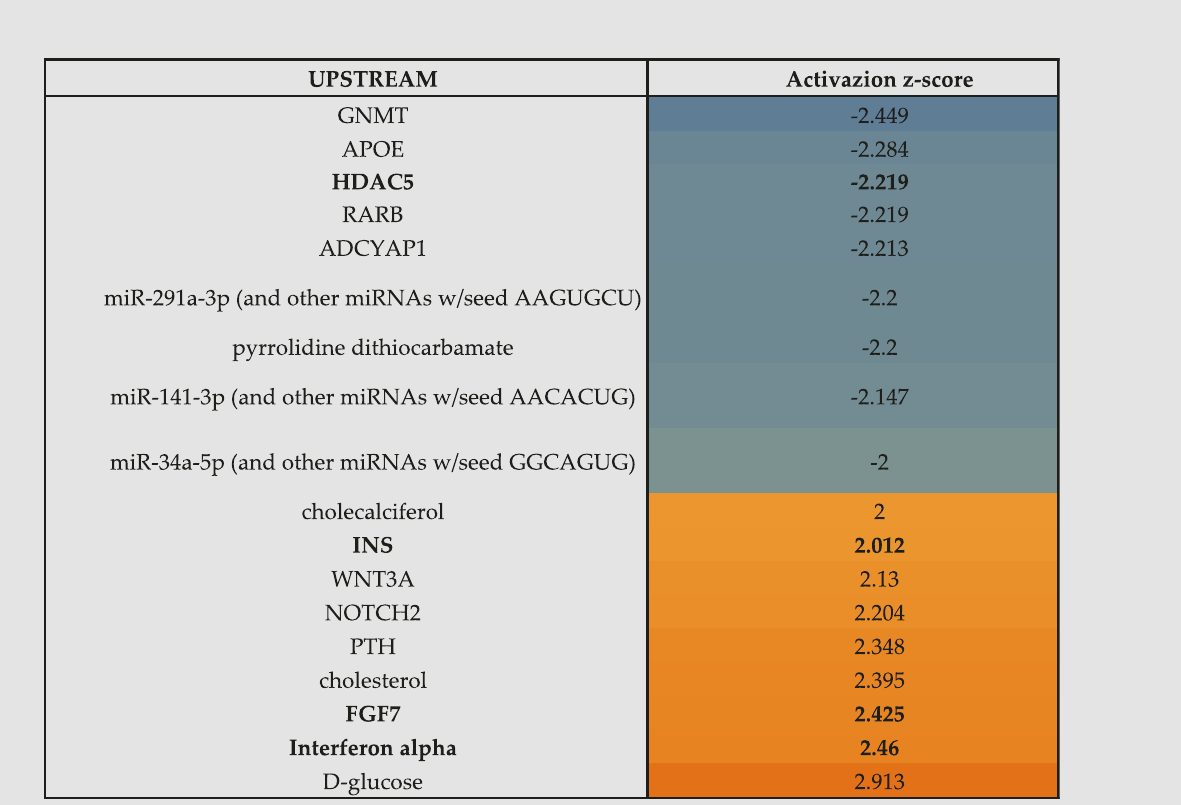
Table 2. List of signi fi cant upstream results only from the integration of Proteomics and Metabolomics data.